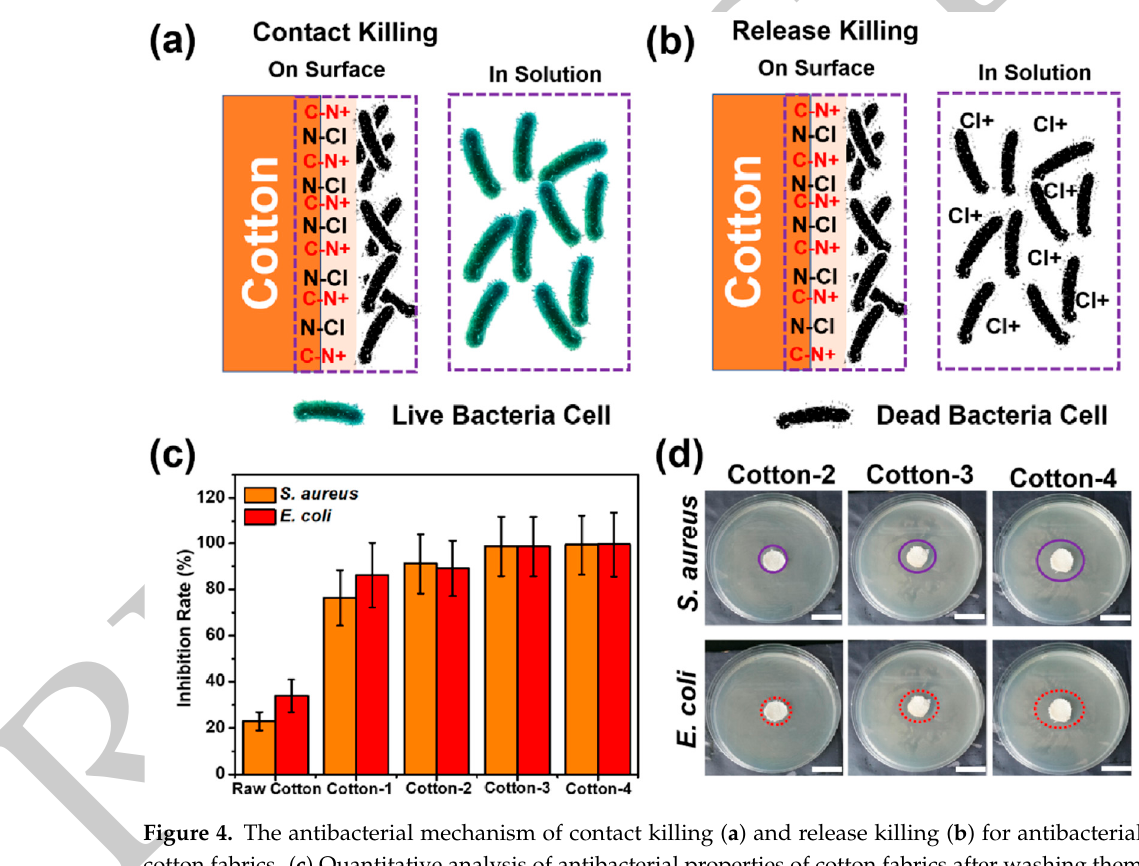
Figure 4. The antibacterial mechanism of contact killing ( a ) and release killing ( b ) for antibacterial cotton fabrics. ( c ) Quantitative analysis of antibacterial properties of cotton fabrics after washing them 50 times without adding anionic detergent. ( d ) The inhibition zones of antibacterial cotton fabrics, the bar is 2 cm.